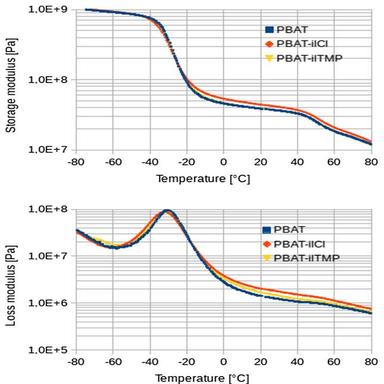
Variation of the storage modulus (top) and of the loss modulus (bottom) of PBAT and PBAT-ILs blends with temperature at 1 Hz.